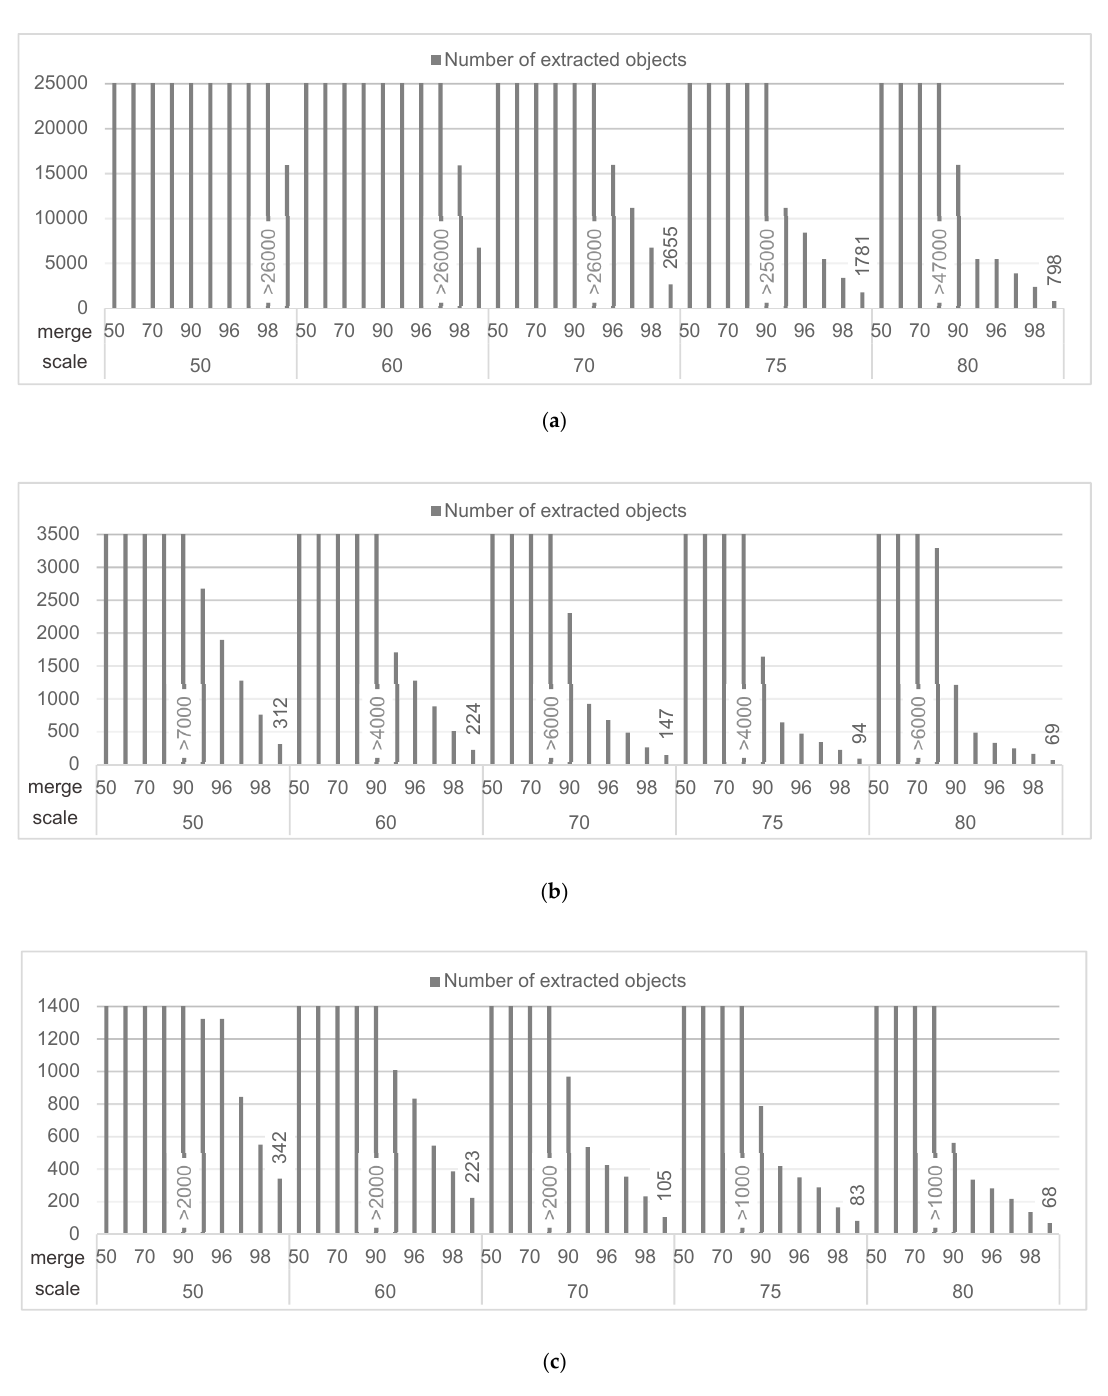
Figure 4. Scale / merge level and number of extracted objects from the resampled UAV orthoimages ( a ) ground sample distance (GSD) 25 cm, ( b ) GSD 50 c, and ( c ) GSD 100 cm. ( a – c ) Grey labels—number of extracted objects outside the range, black labels—the lowest number of extracted objects per scale and merge parameter value.